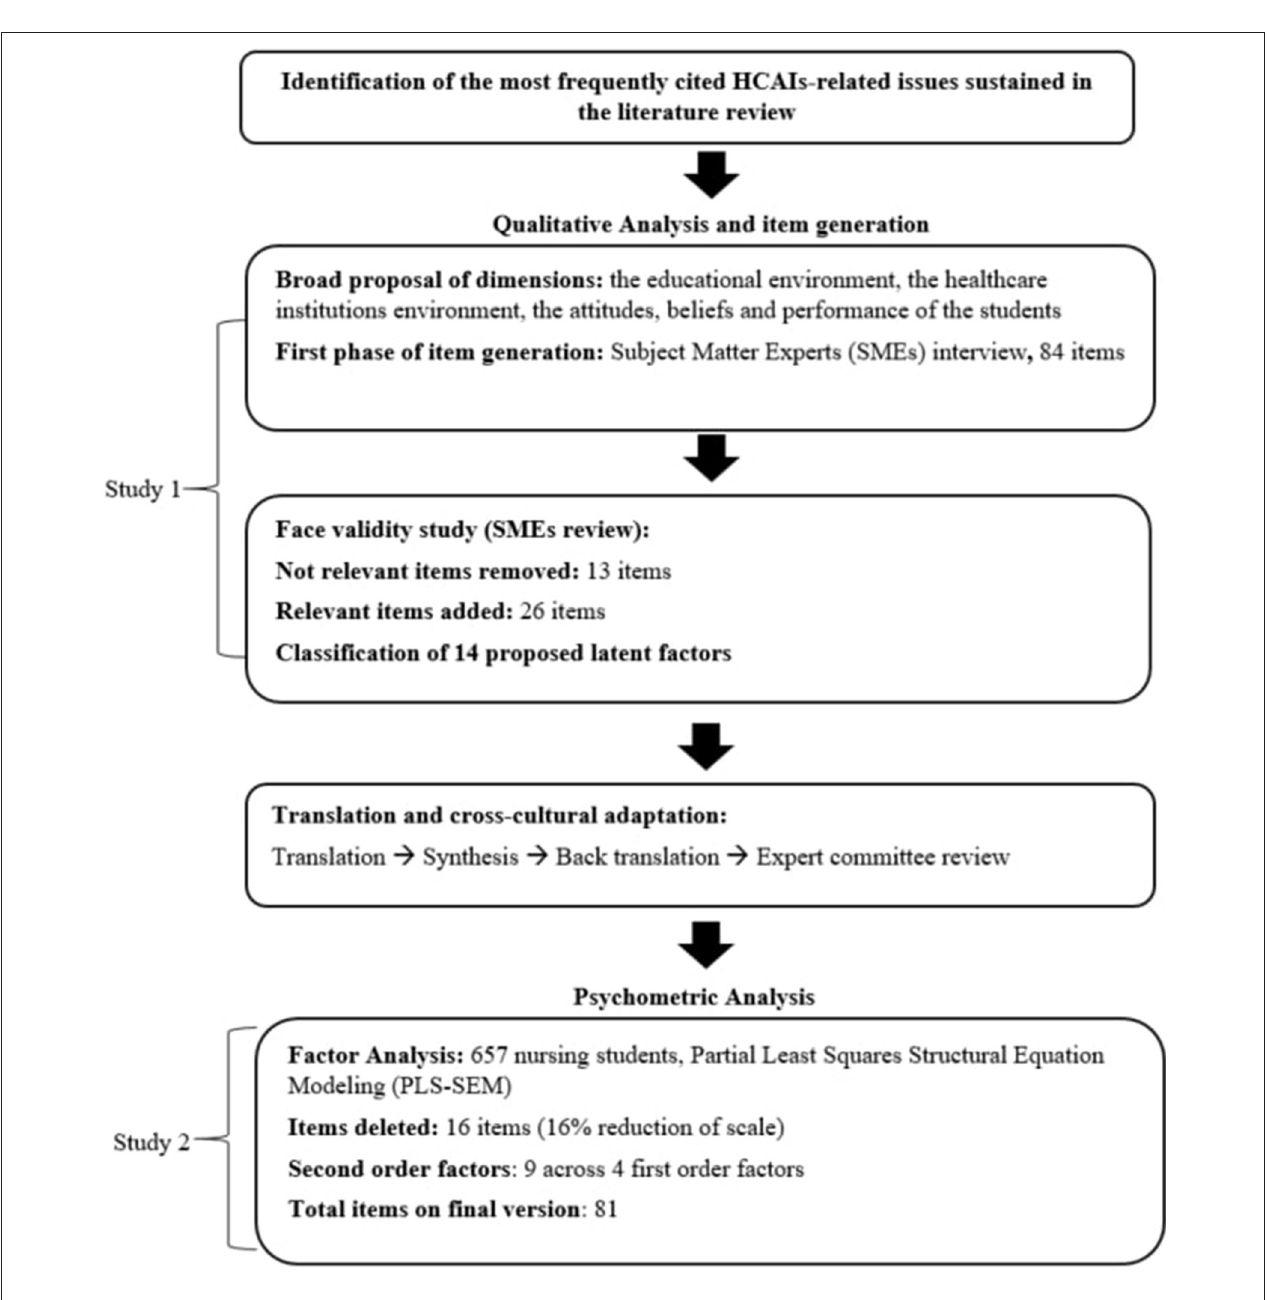
FIGURE 1 | Overview of the InovSafeCare scale development